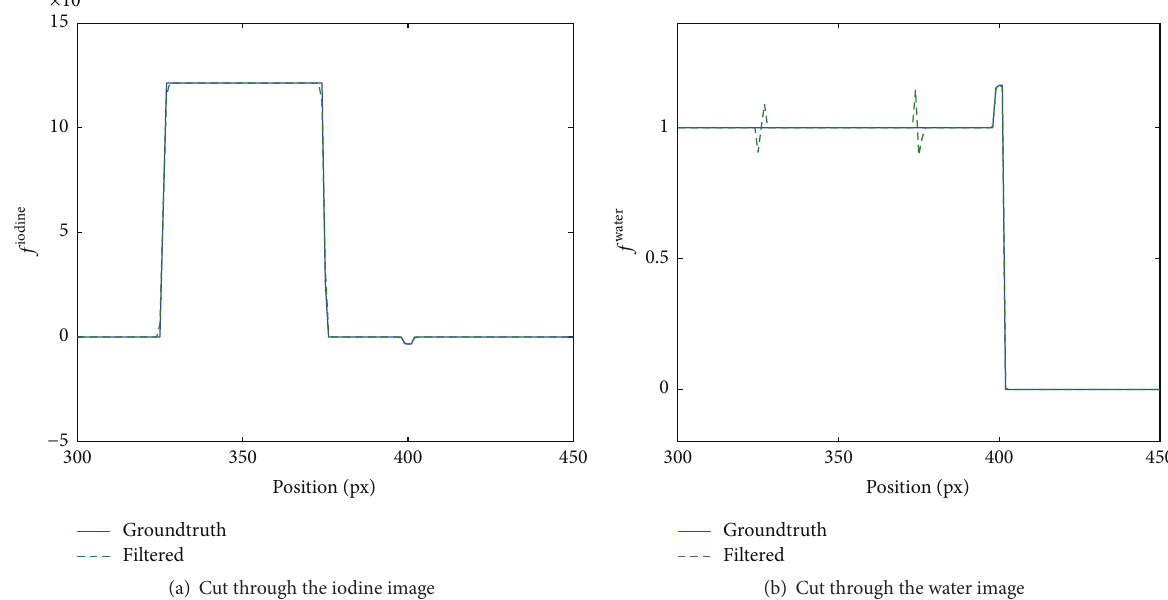
Figure 8: Illustration of the impression of edges from the iodine image onto the water image at 𝐸 = 65 keV (cf. (35)). Shown are cuts through the material images crossing the highest contrast cylinder of the phantom shown in Figure 2.